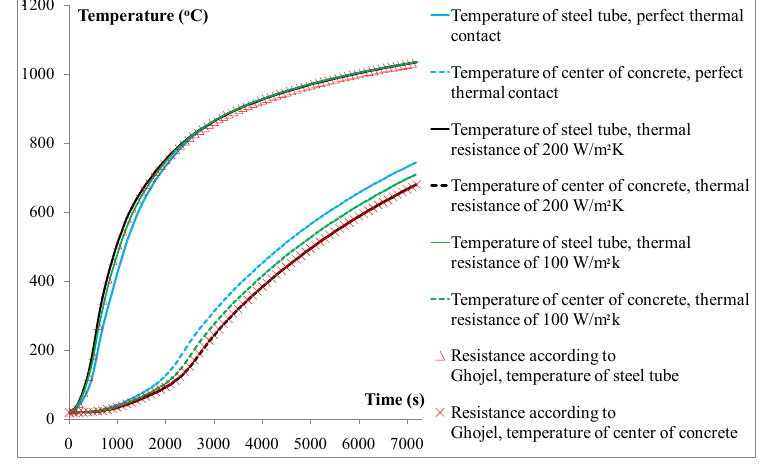
Figure 13. Temperature vs. time, according to thermal resistance tube-concrete interface.